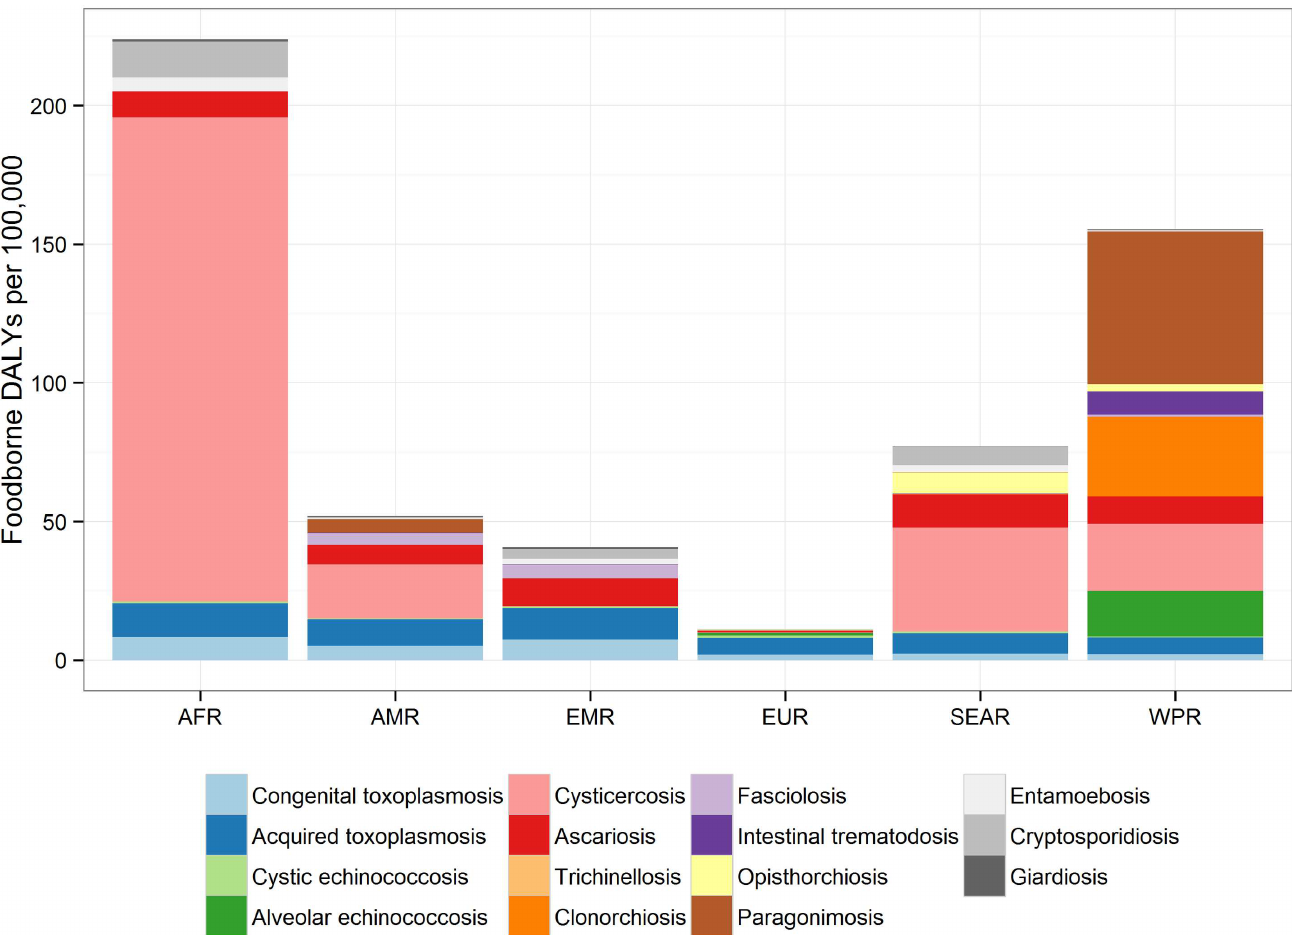
Fig 1. Contribution of each parasite to foodborne disability adjusted life yearsin regions: The relative contribution to the DALY incidence by each agent for each of the regions. This includesenteric protozoato completethe picture on foodborneparasiticdiseases. The figure, title and legendwere taken from Figure 4 in [2] (http://dx.doi.org/10.1371/journal.pmed.1001920.g002). No changeswere made to the originalfigure, title and legendin [2].